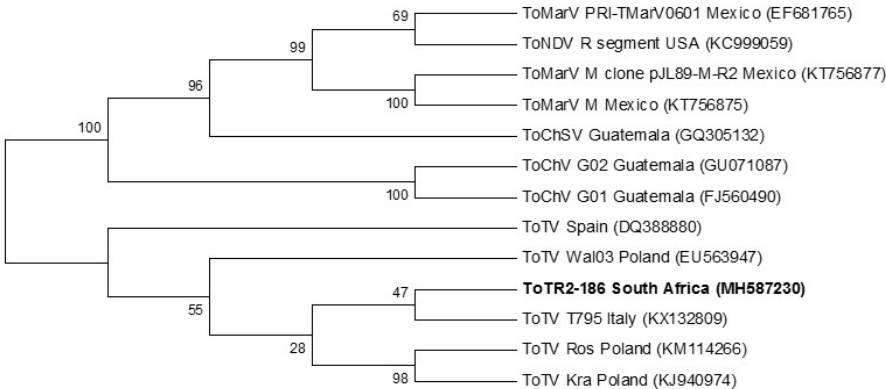
Figure 6. Phylogenetic relationship of the ToTV RNA-2 polyprotein from South Africa in conjunction with all other fully sequenced tomato-infecting torradovirus isolates to date. Evolutionary analysis was carried out in MEGA 6 using the Maximum likelihood method and 1000 bootstrap replicates based on the General Time Reversible model [23]. A gamma distribution rate ( g = 5) was used to model the evolutionary differences among sites. Accession numbers are in parenthesis.